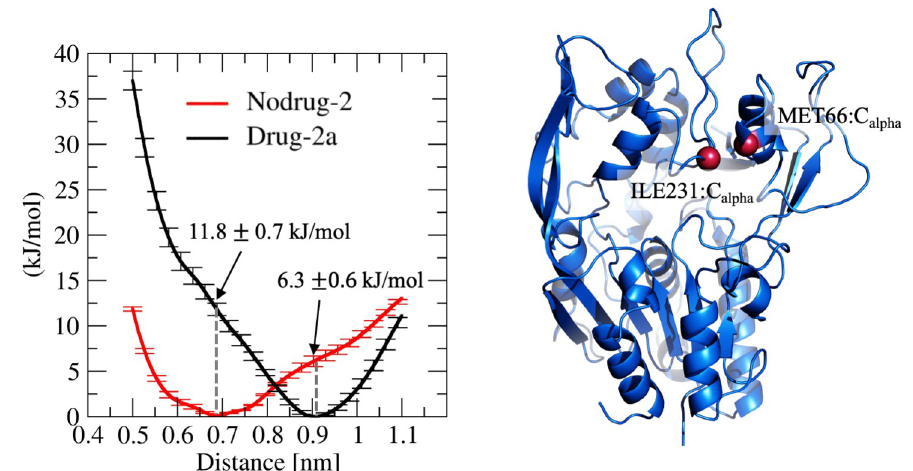
Fig 5. (Left) Spatial energetics of the MBD. The free energy profiles as a function of the distance between M66 and I231 α -carbon atoms with and without compound 2a. (Right) A blue cartoon presentation of LCAT showing the ILE231 and MET66 C α atoms (red spheres) that were used to determine the conformational free energy as a function of distance.